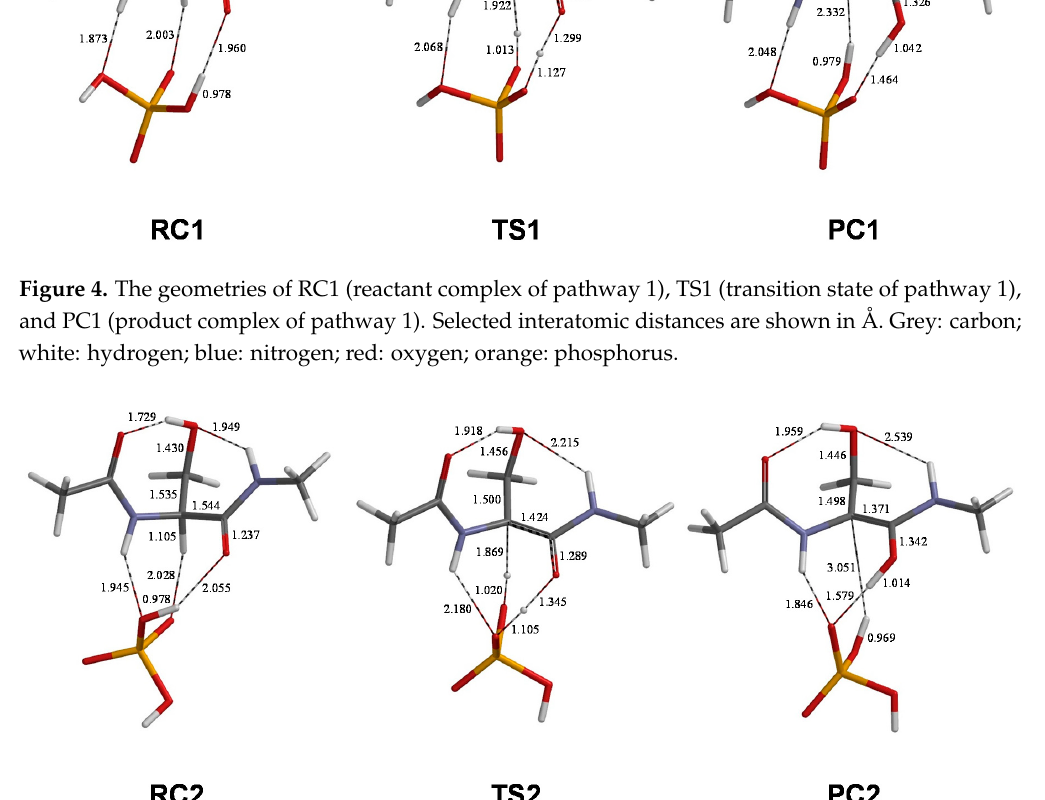
Figure 5. The geometries of RC2 (reactant complex of pathway 2), TS2 (transition state of pathway 2), and PC2 (product complex of pathway 2). Selected interatomic distances are shown in Å. Grey: carbon; white: hydrogen; blue: nitrogen; red: oxygen; orange: phosphorus.